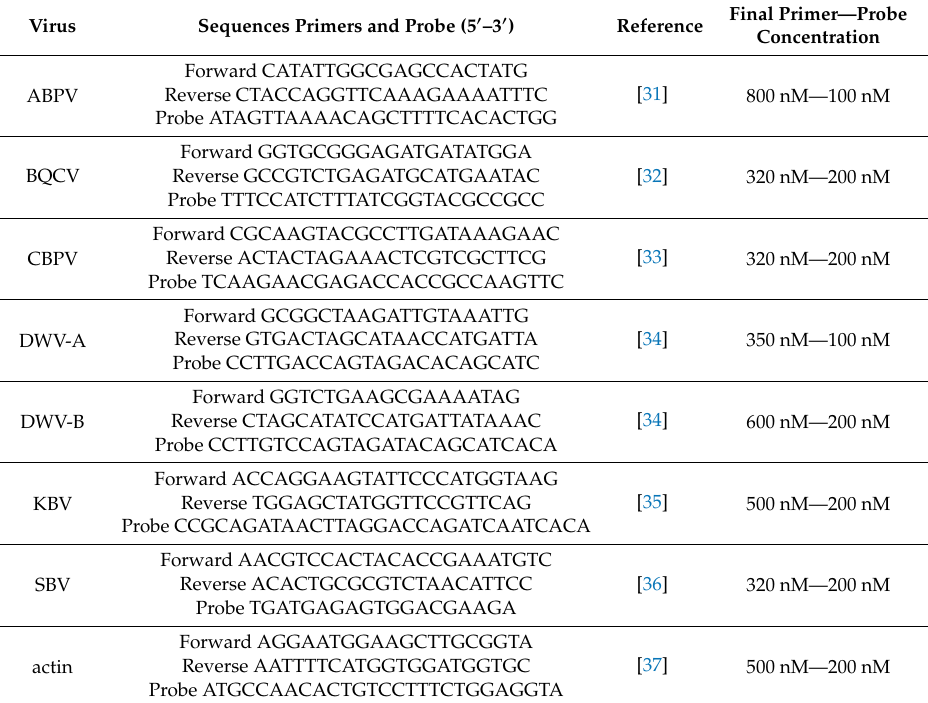
Table 1. Primers and probes used for real time PCR detection of